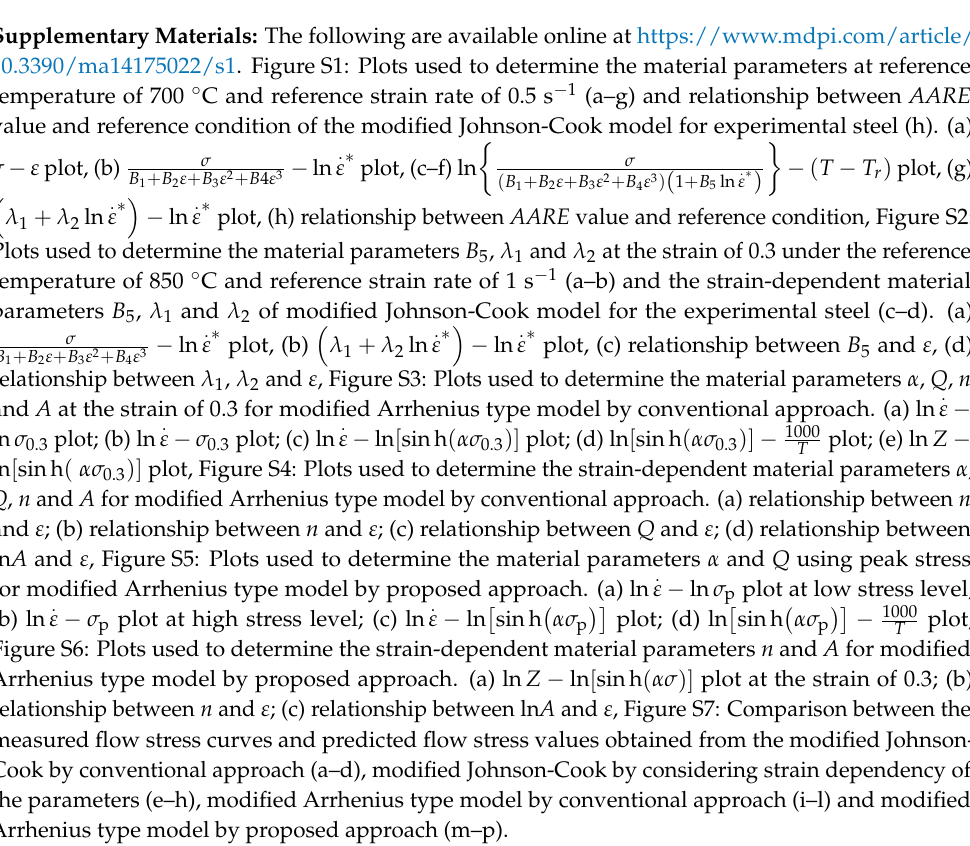
temperature of 700 ◦ C and reference strain rate of 0.5 s − 1 (a–g) and relationship between AARE value and reference condition of the modified Johnson-Cook model for experimental steel (h). (a)